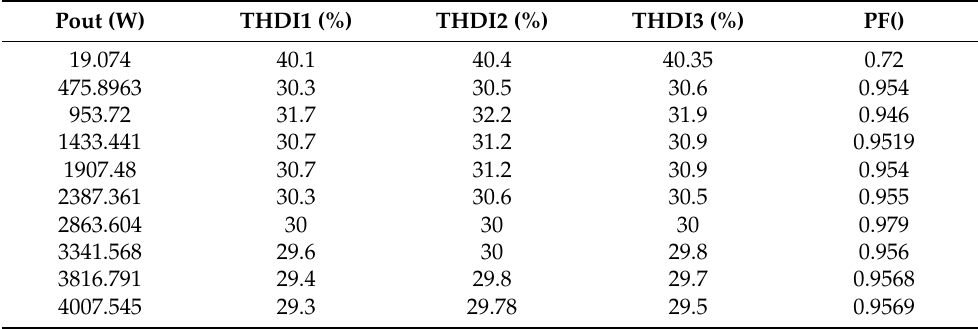
Table A3. THD and PF parameters for original transistor GaN TPH65H050WS and ferrite inductor (operating frequency 200 kHz).